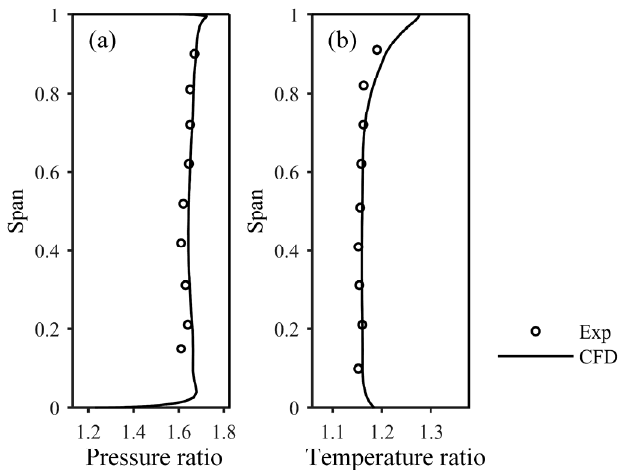
Figure 6. Variable distributions in the span of the experiment [33] and CFD: ( a ) pressure distribution in the span; ( b ) temperature distribution in the span.